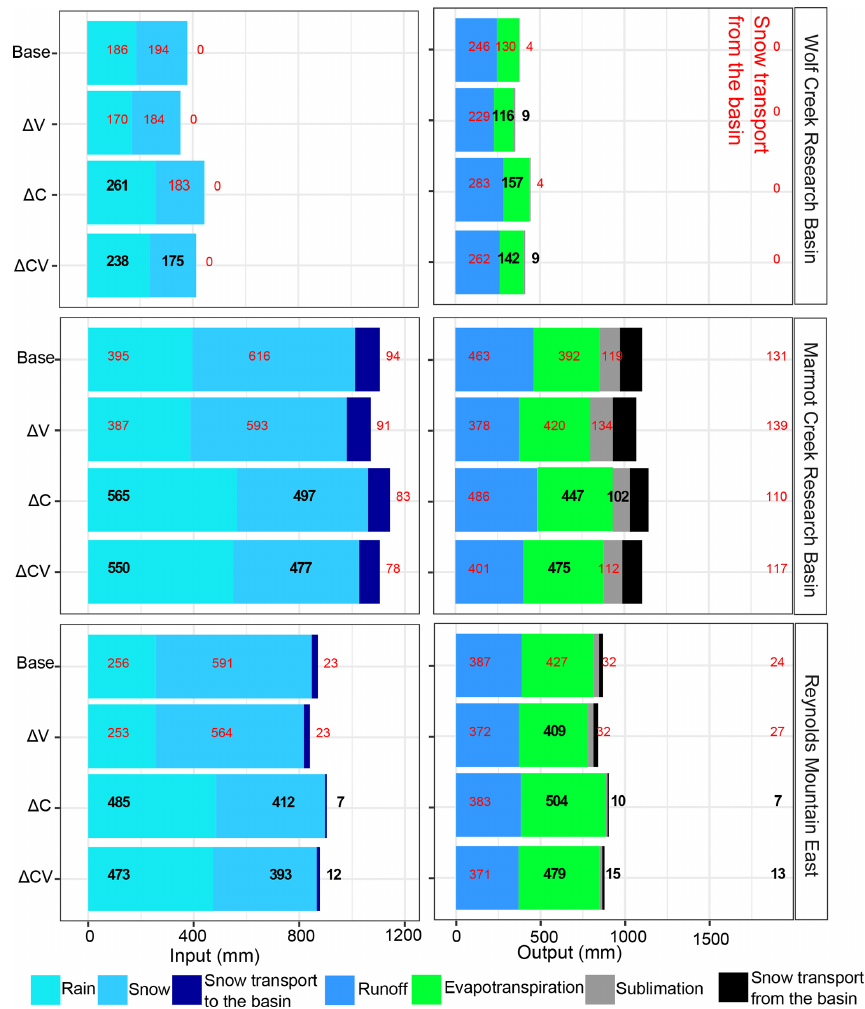
Figure 7. Mean modeled water fluxes, in the (three) liquid, vapor, and snow states, under current climate and current vegetation (base), future climate and current vegetation ( (cid:49)C ), current climate and future vegetation ( (cid:49)V ), and future climate and future vegetation ( (cid:49)V C ) in the Wolf Creek Research Basin, the Marmot Creek Research Basin, and Reynolds Mountain. Statistically significant differences in the climatological mean of the simulated variables with p values of less than 0.05 are represented using bold and black